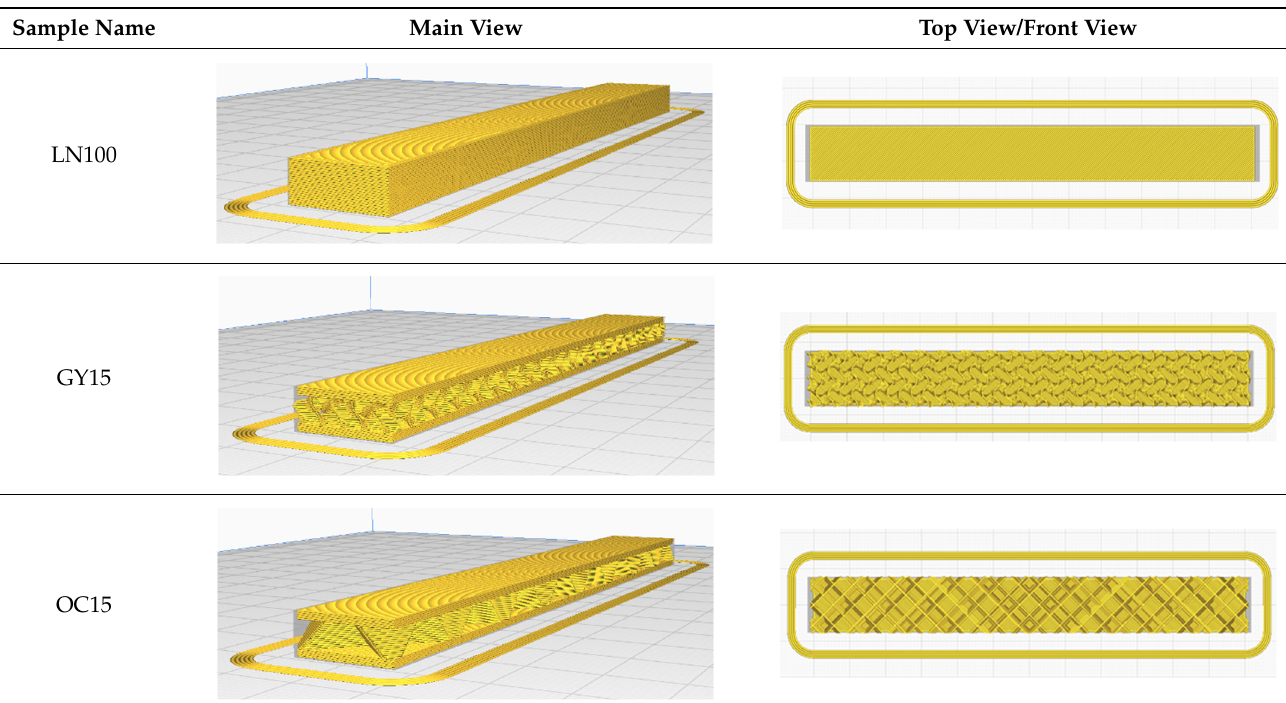
(Table 1): pattern line with 100% infill and 80% printing speed (LN100); pattern gyroid